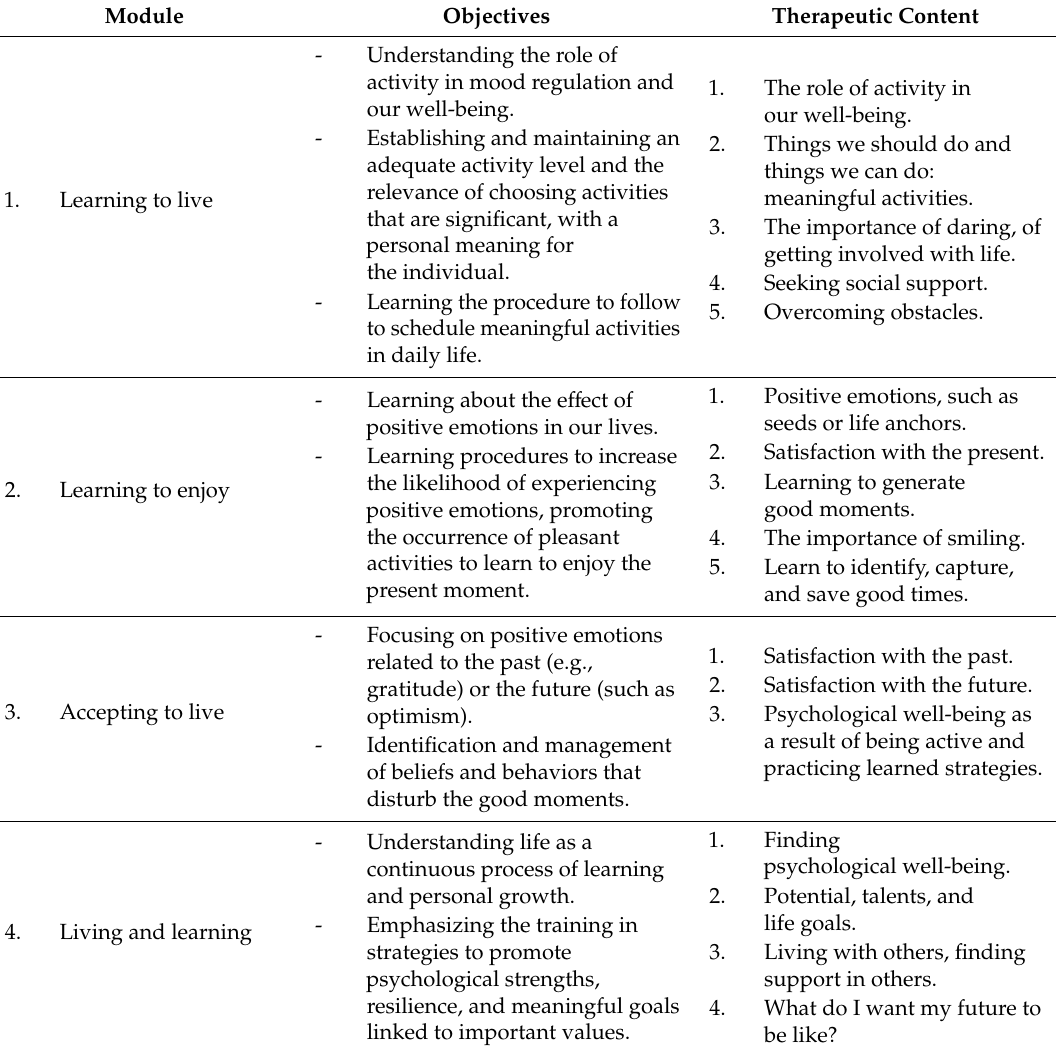
Table1. Modules, objectives,